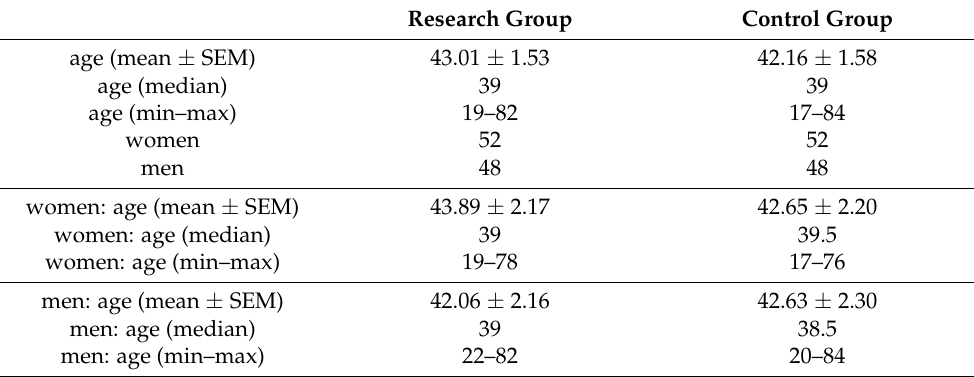
Table 2. Demographic characteristics of research and control